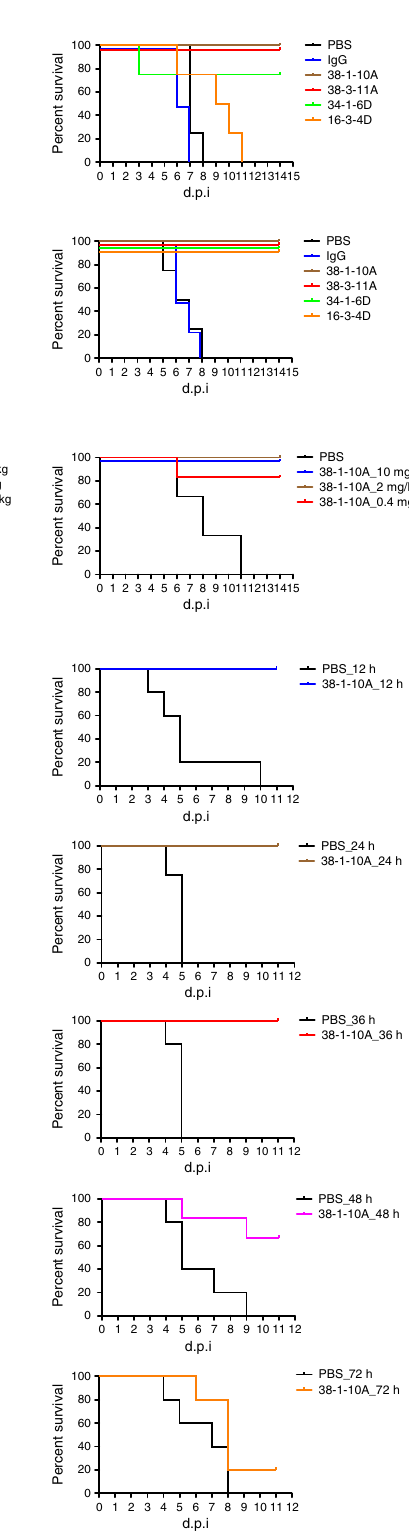
fi t well with the EM map with minor adjustments of some surface loops and side chains. The crystal structure of EV71 (PDB ID 3VBS) 7 also fi tted well into the EM map of both complexes. Based on the B-factors after re fi nement and the strength of the density, the occupancy of the Fab in the EV71/38-1-10A complex was estimated to be approximately 40%. In contrast the Fab